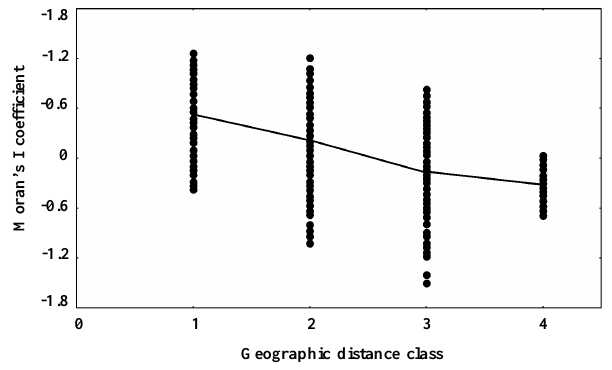
Figure 2 - Spatial correlograms obtained with simulated data. The average correlogram is shown by the solid line. See Figure 3 to examine the linear decrease in most of these correlograms.